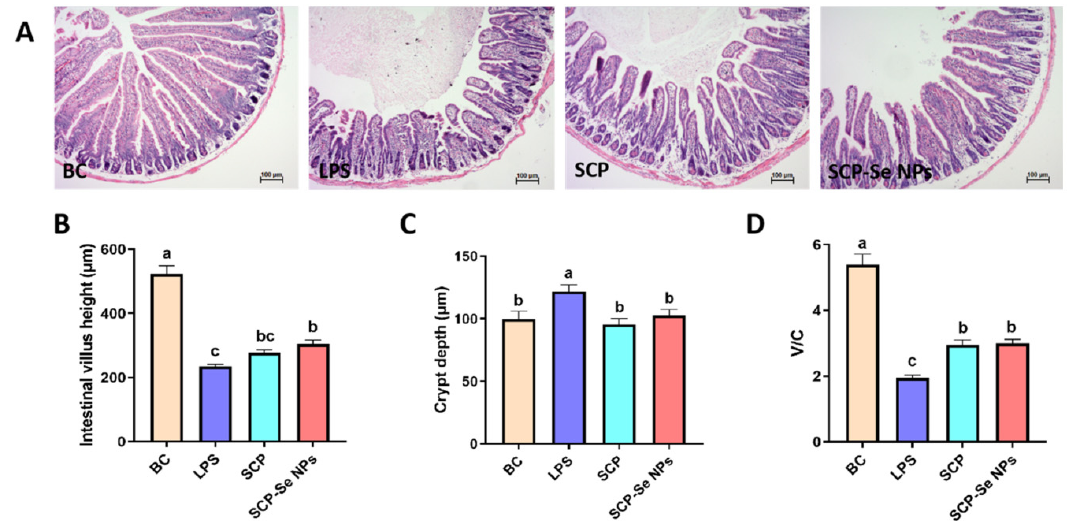
Figure 9. Effect of SCP-Se NPs on LPS-induced intestinal injuries in mice. ( A ) Effect of SCP-Se NPs on the histopathological changes in the jejunum ( × 100 magnification). ( B ) Jejunum villus height in each group. ( C ) Jejunum crypt depth in each group. ( D ) The ratio of jejunum villus height to crypt depth in each group. Different lowercase letters (a–c) indicate significant differences ( p < 0.05).